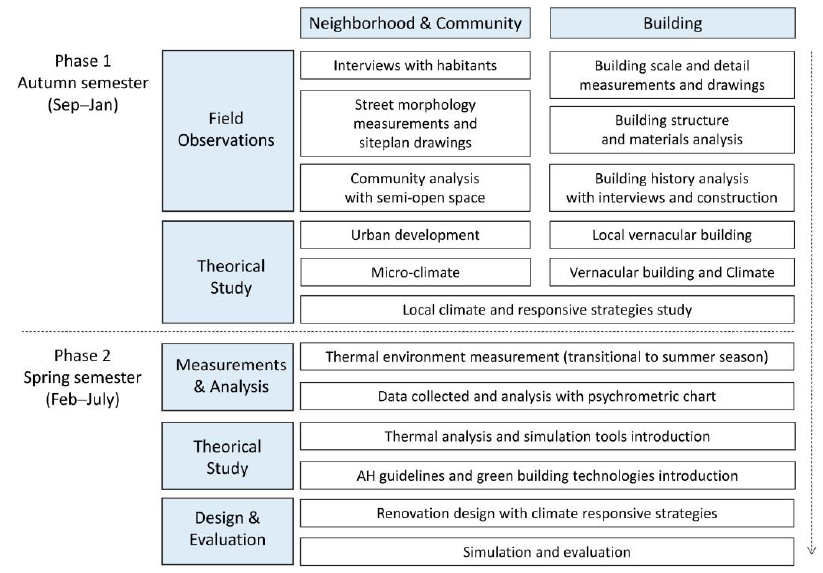
Figure 5. Methodologies and process of the program.